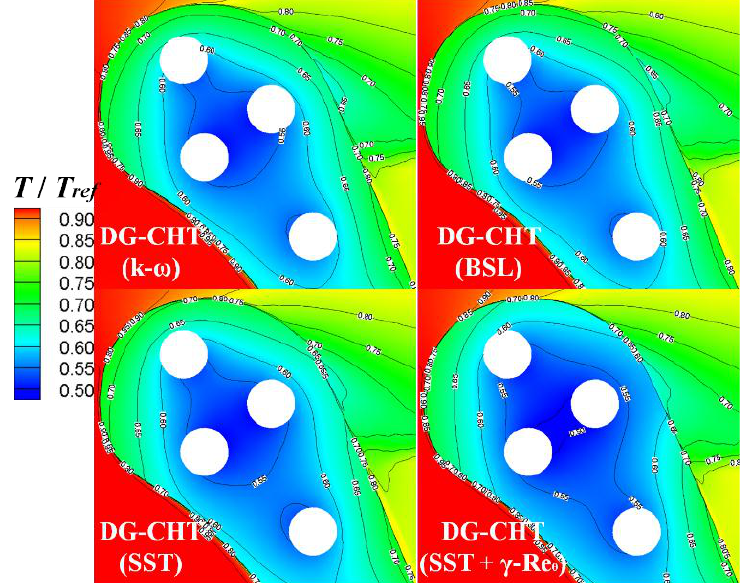
Figure 15. Temperature contours around leading edge of the